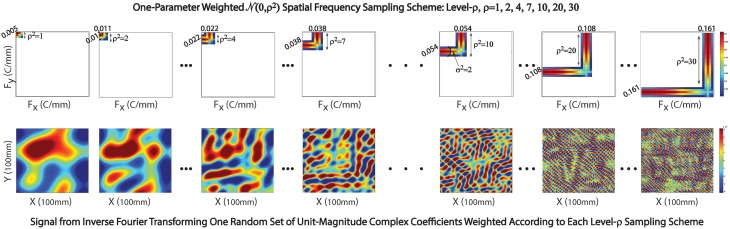
Sampling scheme in exhibited in 2D setting. Top Row: The Gaussian weighting scheme centered at (x,y) spatial frequencies with indices ρ = 1, 2, 4, 7, 10, 20, and 30; Bottom Row: Corresponding 2D spatial signals generated by inverse Fourier transforming a random set of unit-magnitude complex coefficients, weighting according to the sampling scheme displayed immediately above.